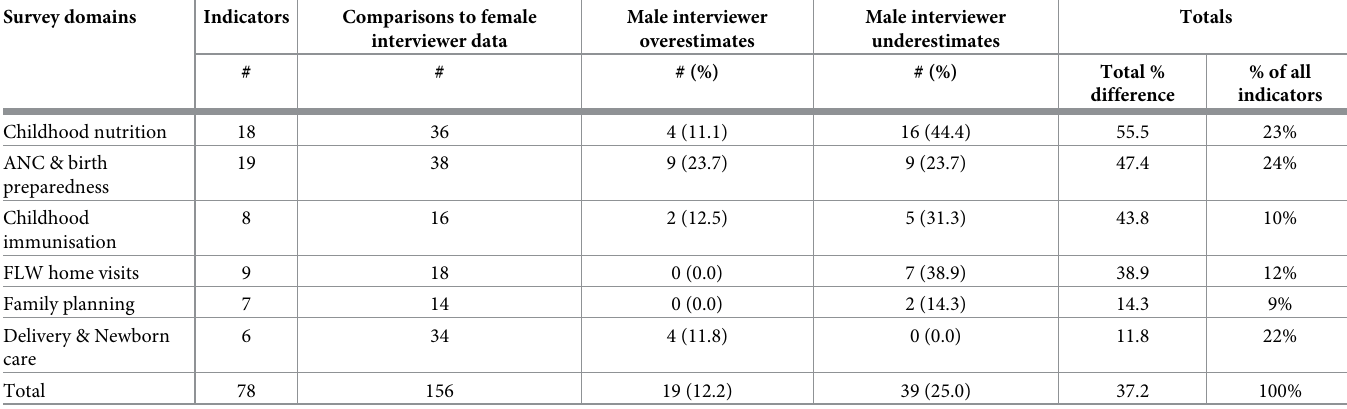
Table 2. Significantly different results from data collected by male interviewers compared with data collected by female interviewers in Bihar, India. Survey